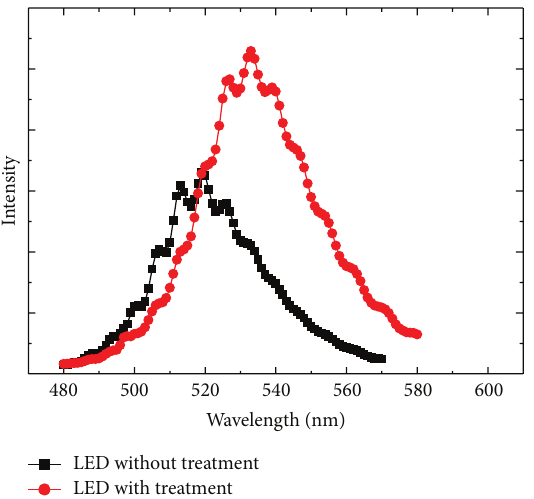
Figure4:Room-temperaturephotoluminescencespectrafortheLEDspreparedwithoutandwithTMIntreatment,withcentralpeakslocated at 520 and 535 nm, respectively.